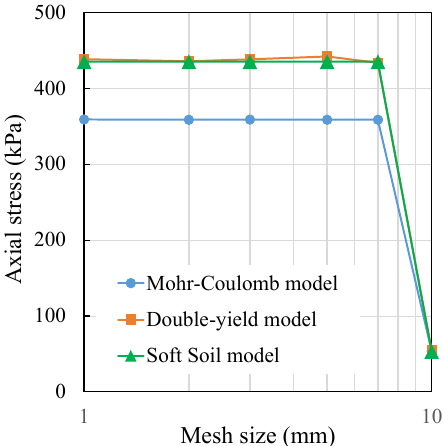
Figure A12. Variation of axial stress under an axial strain of 5% and a confining pressure of 200 kPa in triaxial compression simulations as functions of the mesh size.